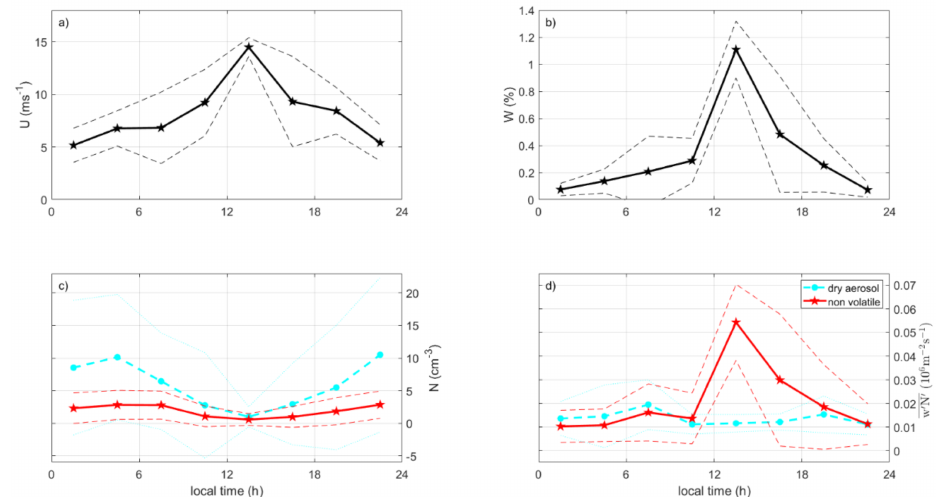
Figure 10. Diurnal average cycles of ambient in situ parameters as measured by the eddy covariance flux system on Garpen. The figure is based on all data within the coastal wind sector (205–270 ◦ ) that coincides with data from the tank experiment. ( a ) Diurnal cycle in wind speed (solid curve) with one standard deviation (dashed curves). ( b ) Like ( a ), but for the white cap coverage. ( c ) Like ( a ), but for OPC number concentrations, dry aerosol (cyan curve), and non-volatile (red curve), with respective standard deviations (dotted and dashed curves, respectively). ( d ) As in ( c ), but for the average of all upward aerosol number